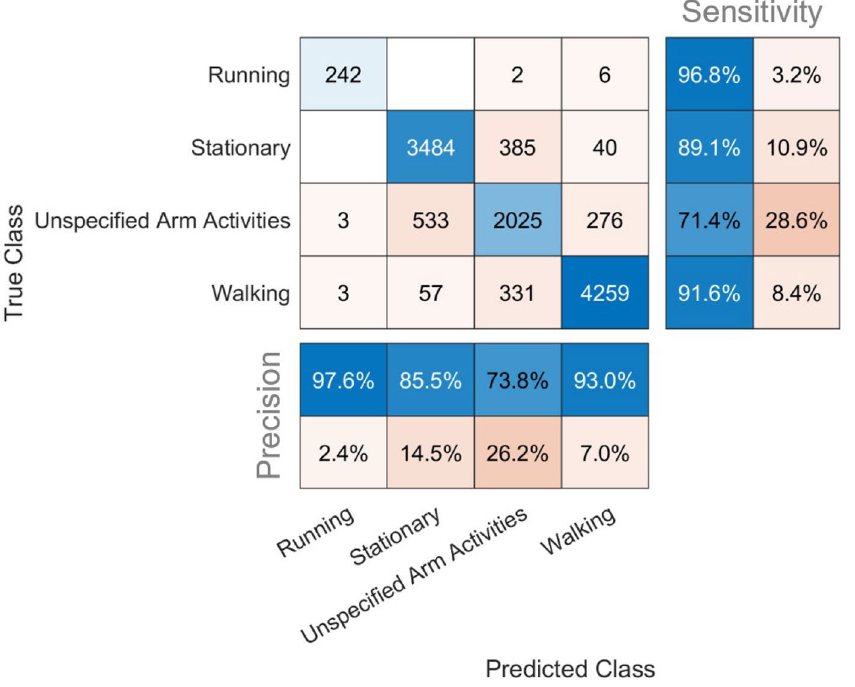
Figure 1. Confusion matrix of stage 1 classification. N = 101 with 11,646 4-s windows. The blue column on the far right of these matrices displays the percentage of correctly identified windows over all the windows that actually belong to that category (i.e. sensitivity). The blue column at the bottom of the matrices represents the percentage of correctly identified windows over all windows that were predicted to be of that category (i.e.